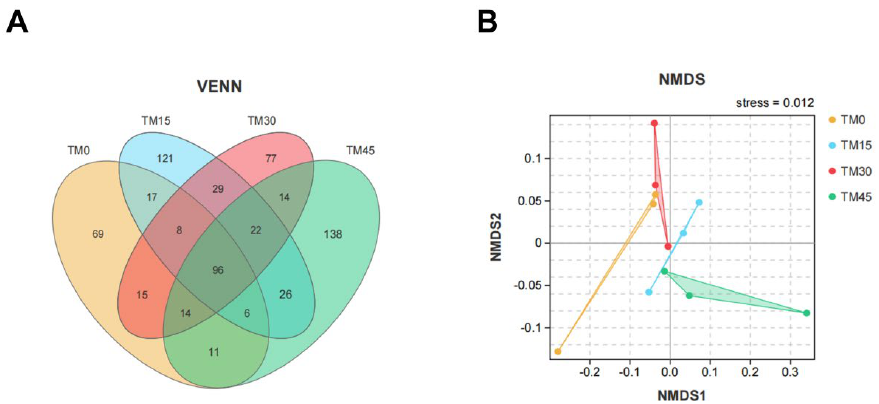
Figure 4. ( A ) Venn diagram, ( B ) non-metric multidimensional scale analysis (NMDS) based on